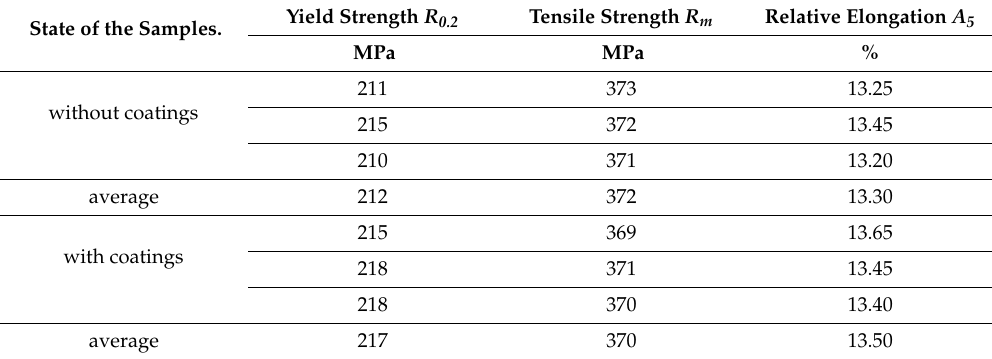
Table 2. Mechanical properties of AlMg6 alloy samples without coatings and with coatings. State of the